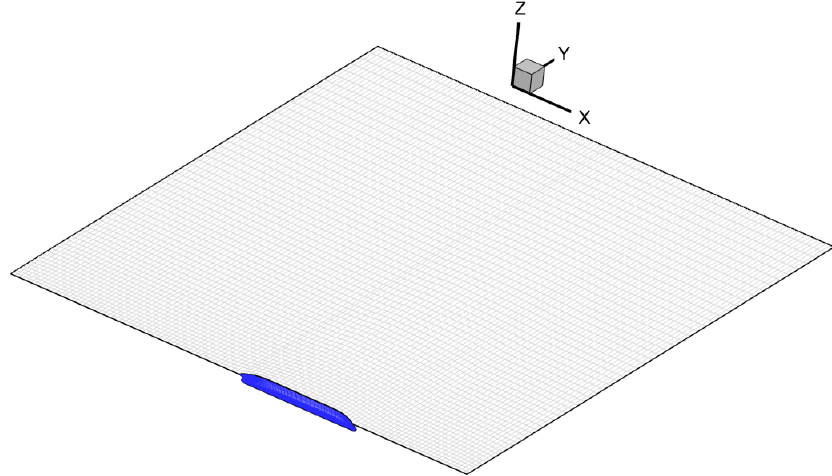
Figure 14. Panels modeled over the free surface.